Question: State the chart type depicted above.
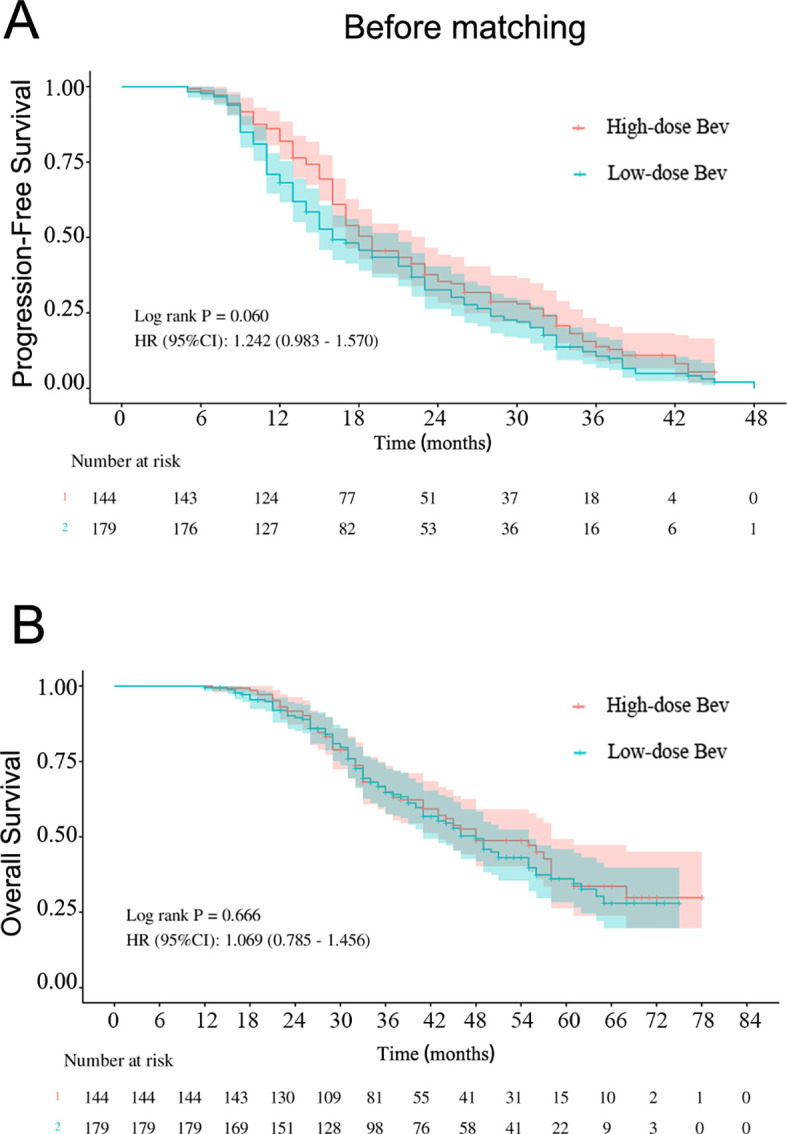
Answer: survival